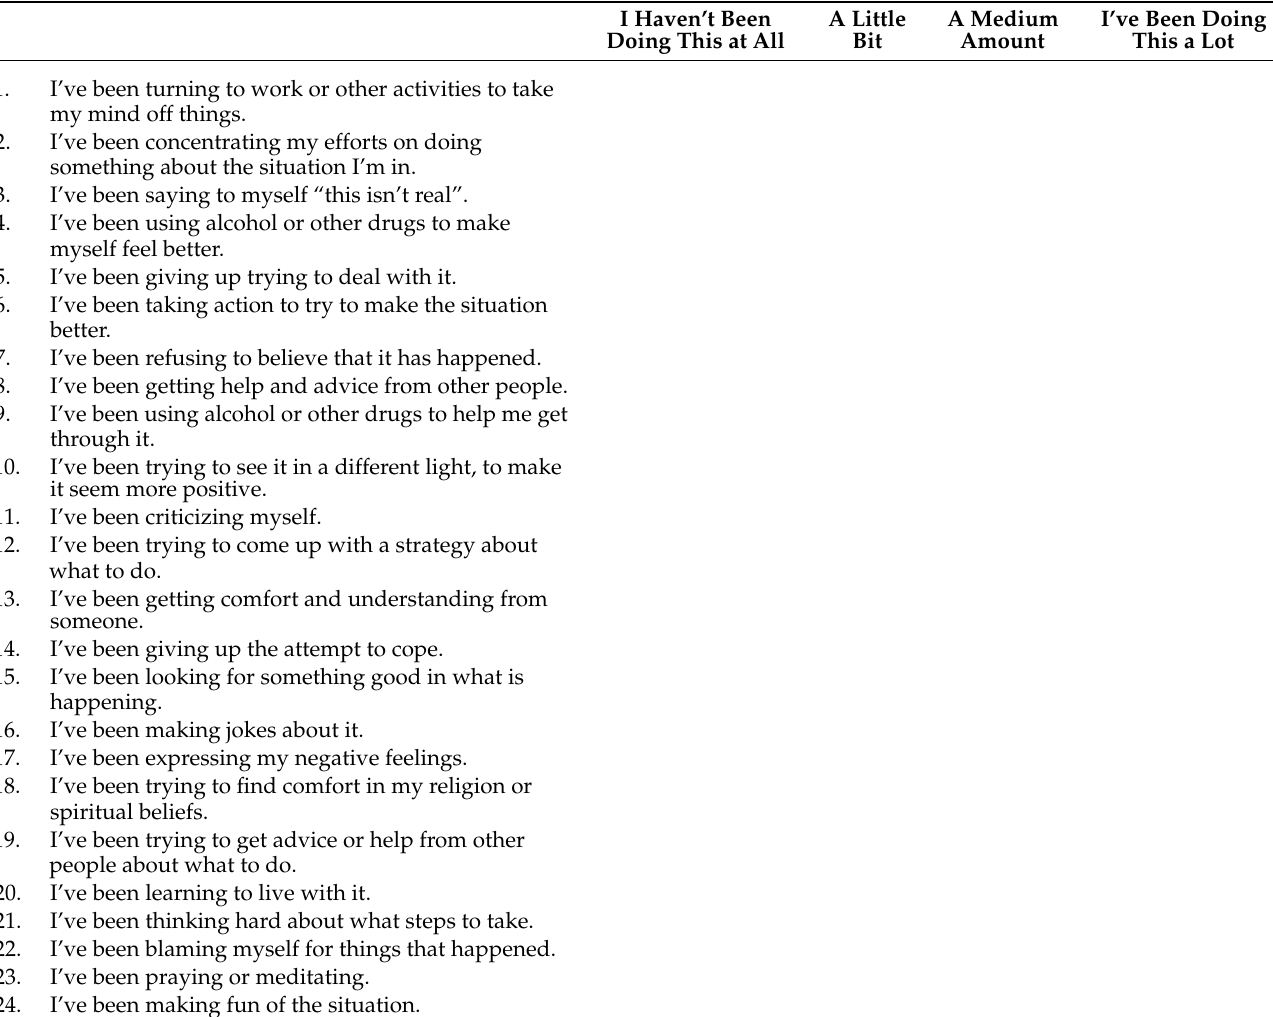
Table A2. Revised Brief COPE